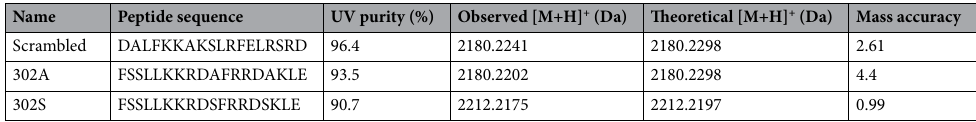
Table 1. cMyBP-C peptides sequence and characterization. cMyBP-C peptides were generated and characterized by high-resolution mass spectrometry. All peptide samples have purity values near or above 90% with accurate mass values in line with expectation based on the